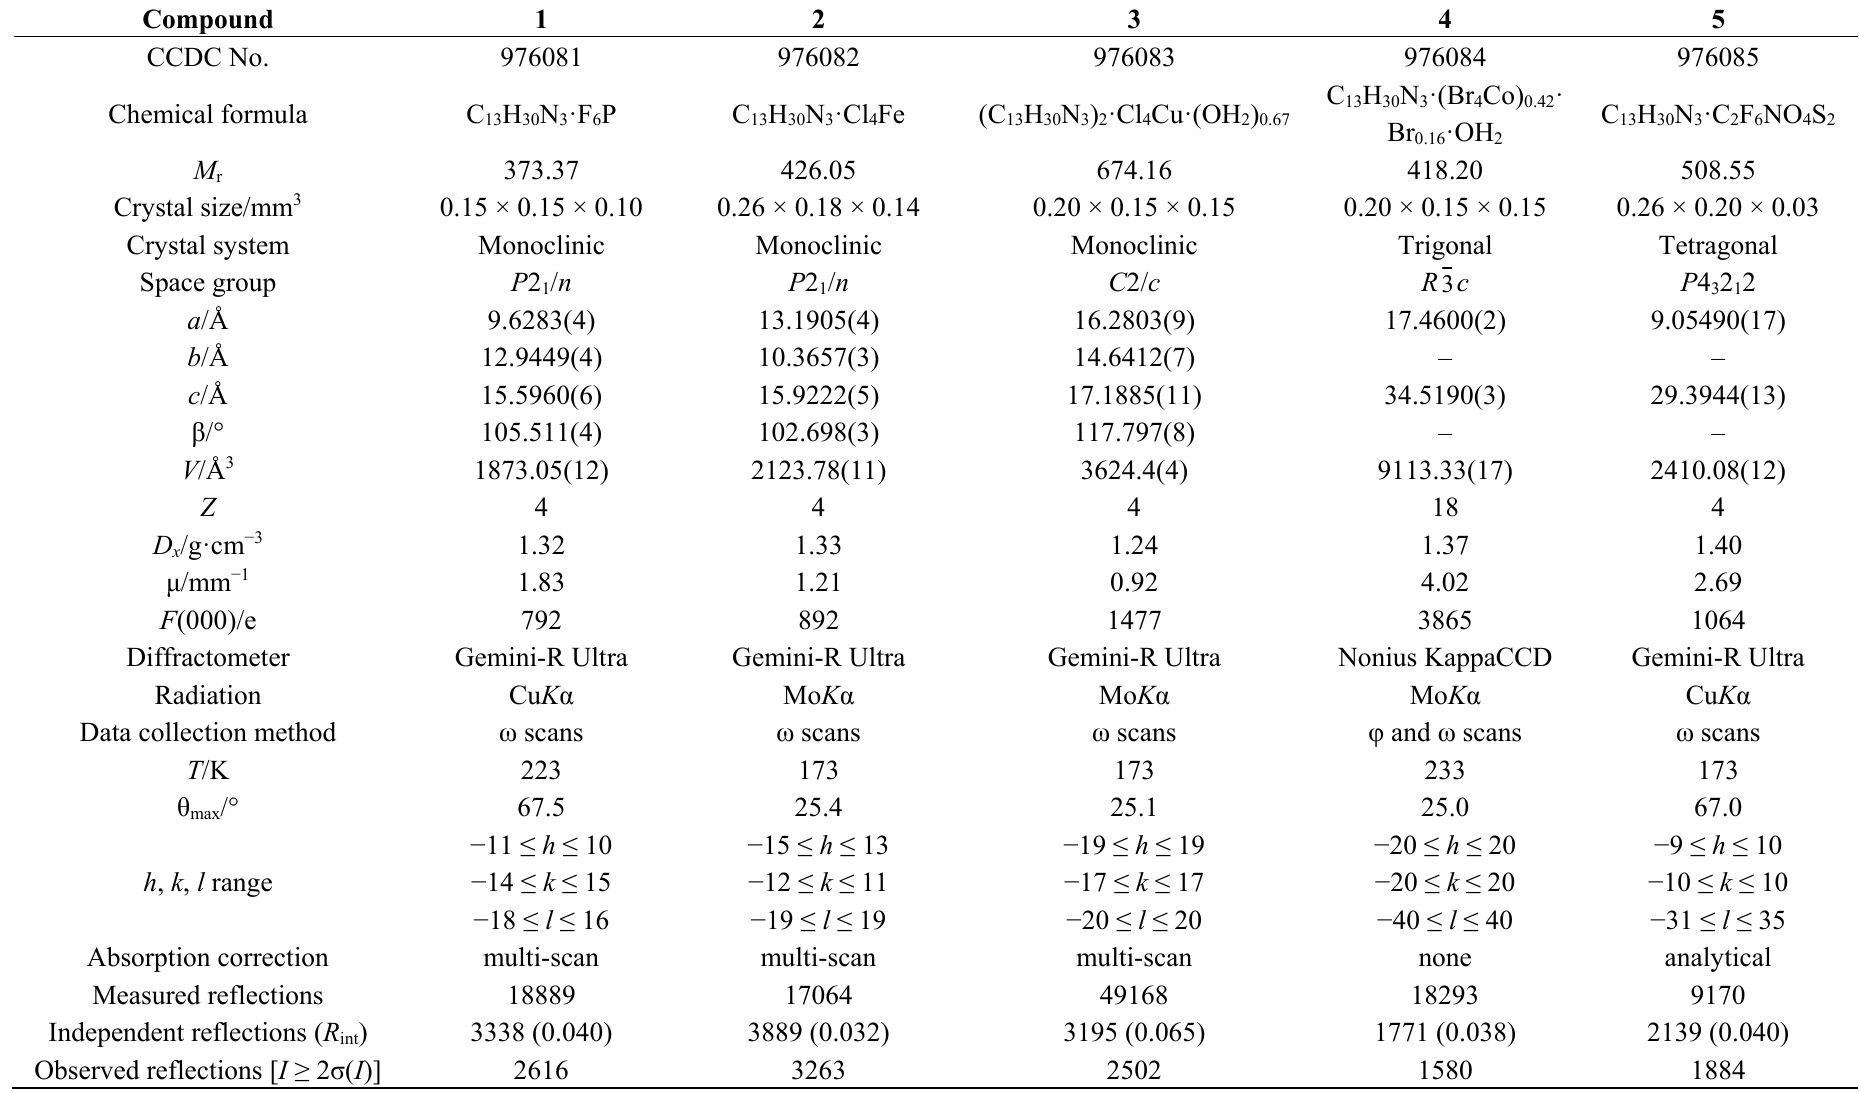
Table 1. Crystal data and structure refinement